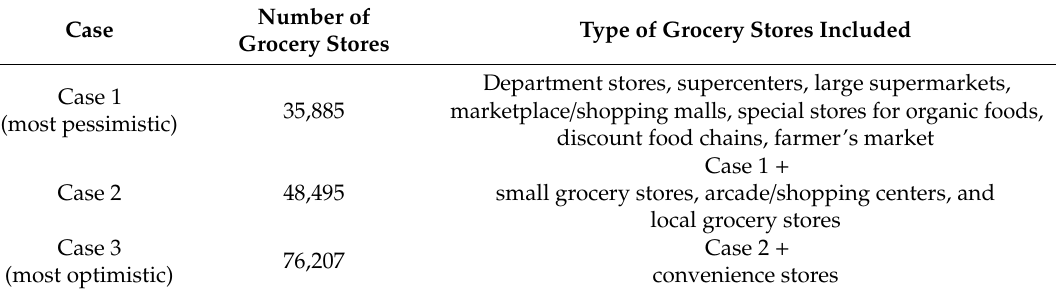
Table 1. Cases (Scenarios) according to the inclusion criteria of grocery